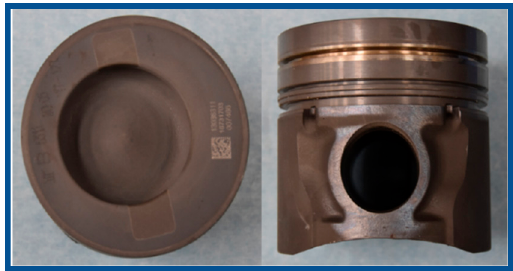
Figure 1. Conventional piston before spraying.